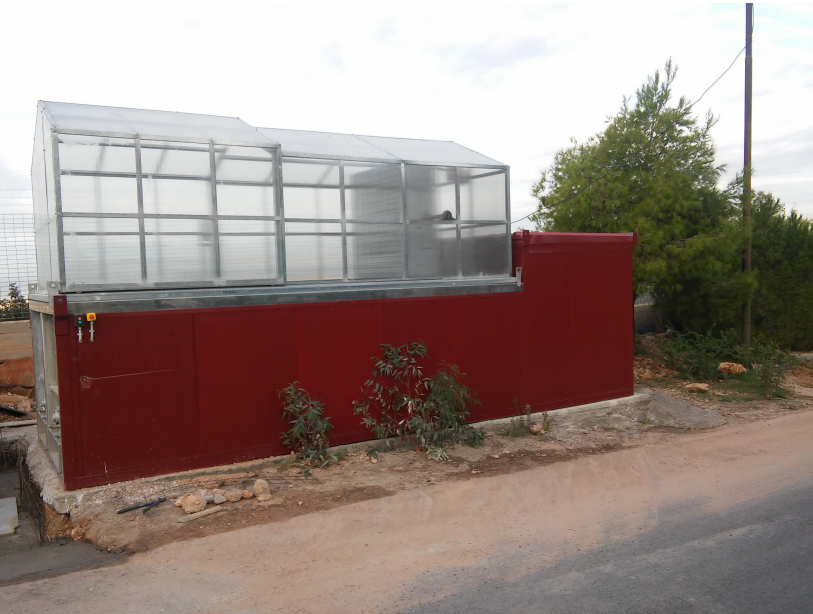
Figure 4. Real-life composting frame.